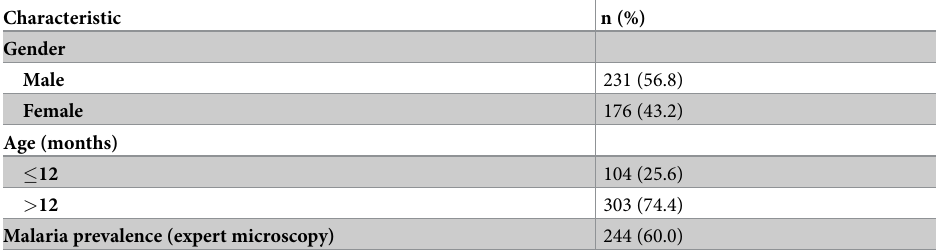
Table 1. Characteristics of the study population (children under the age of 5 years with an axillary temperature of > 37.5˚C).